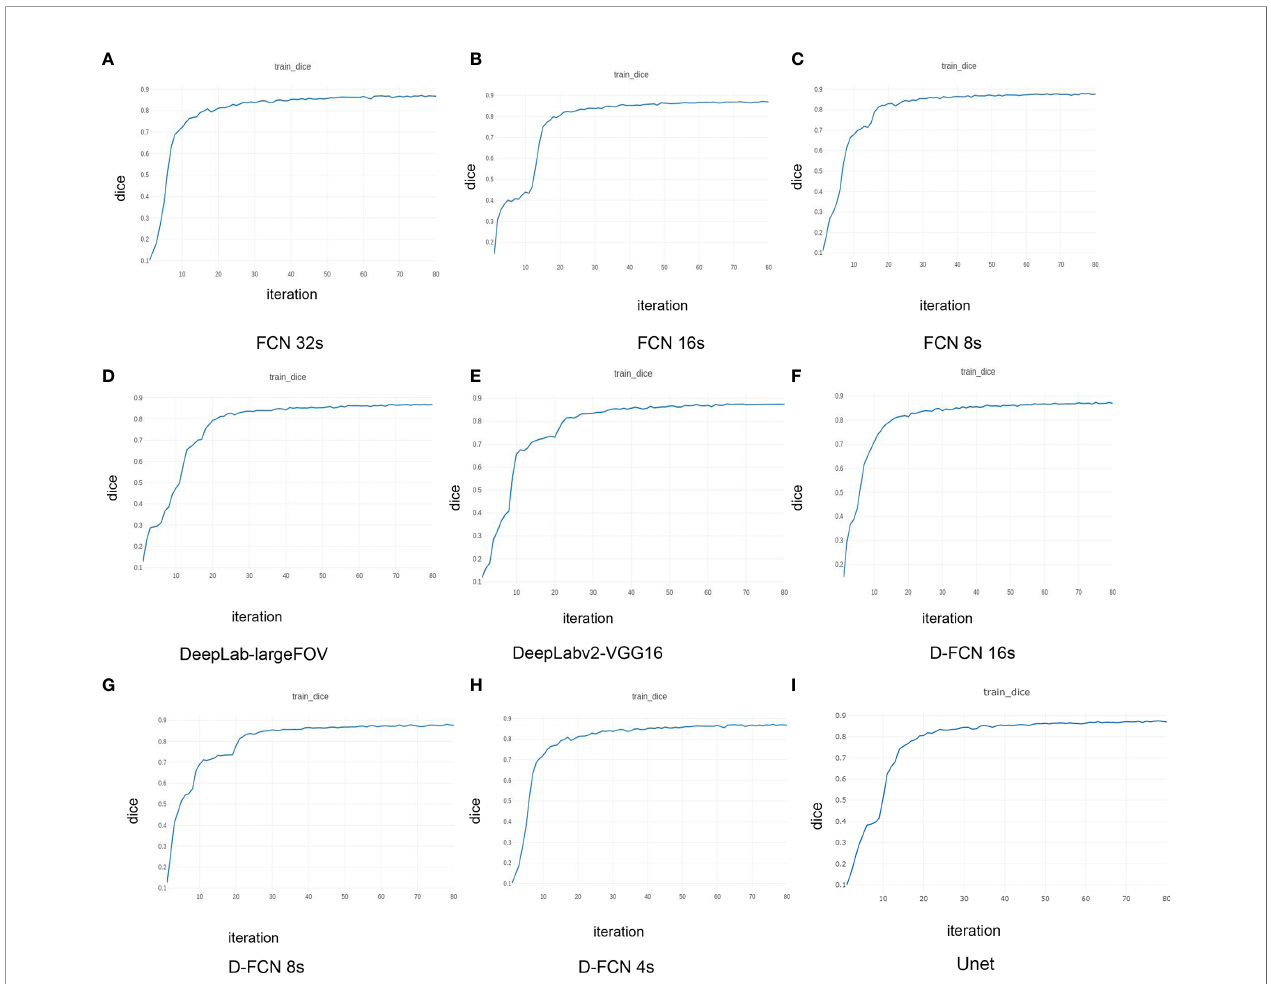
FIGURE 3 | | Dice curves of the training effects of the 8 network models. (A) is the Dice curve of the training effect of FCN 32s network; (B) is of FCN 16s network; (C) is of FCN 8s network; (D) is of DeepLab-largeFOV network; (E) is of DeepLabv2-VGG16 network; (F) is of D-FCN 16s network; (G) is of D-FCN 8s network; (H) is of D-FCN 4s network; (I) is of Unet